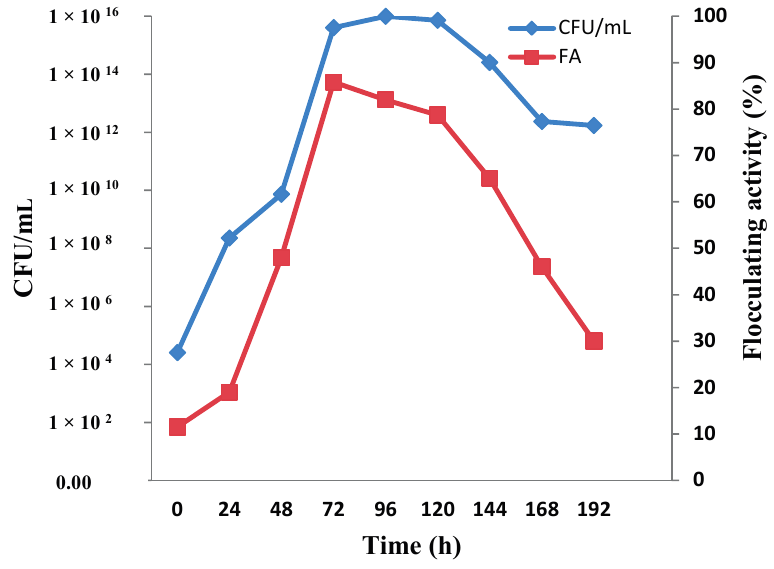
Figure 1. Time course of bioflocculant production by Bacillus sp.